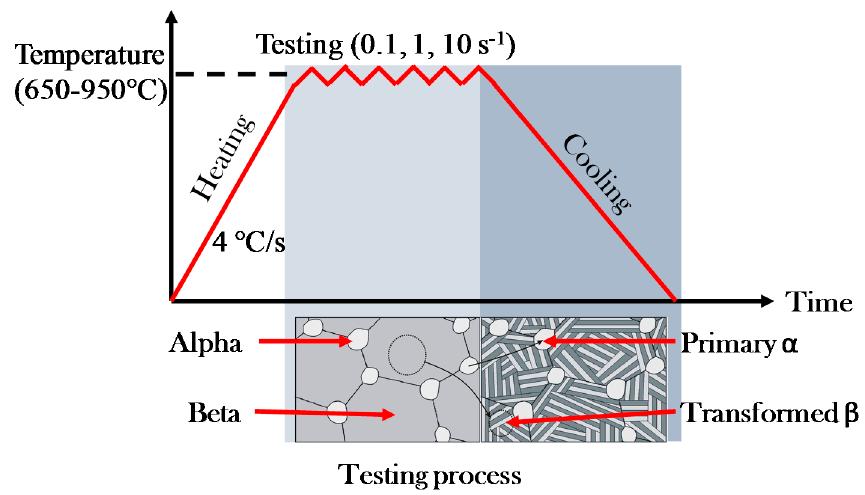
Figure 4. The temperature profile of the specimen during hot tensile tests.